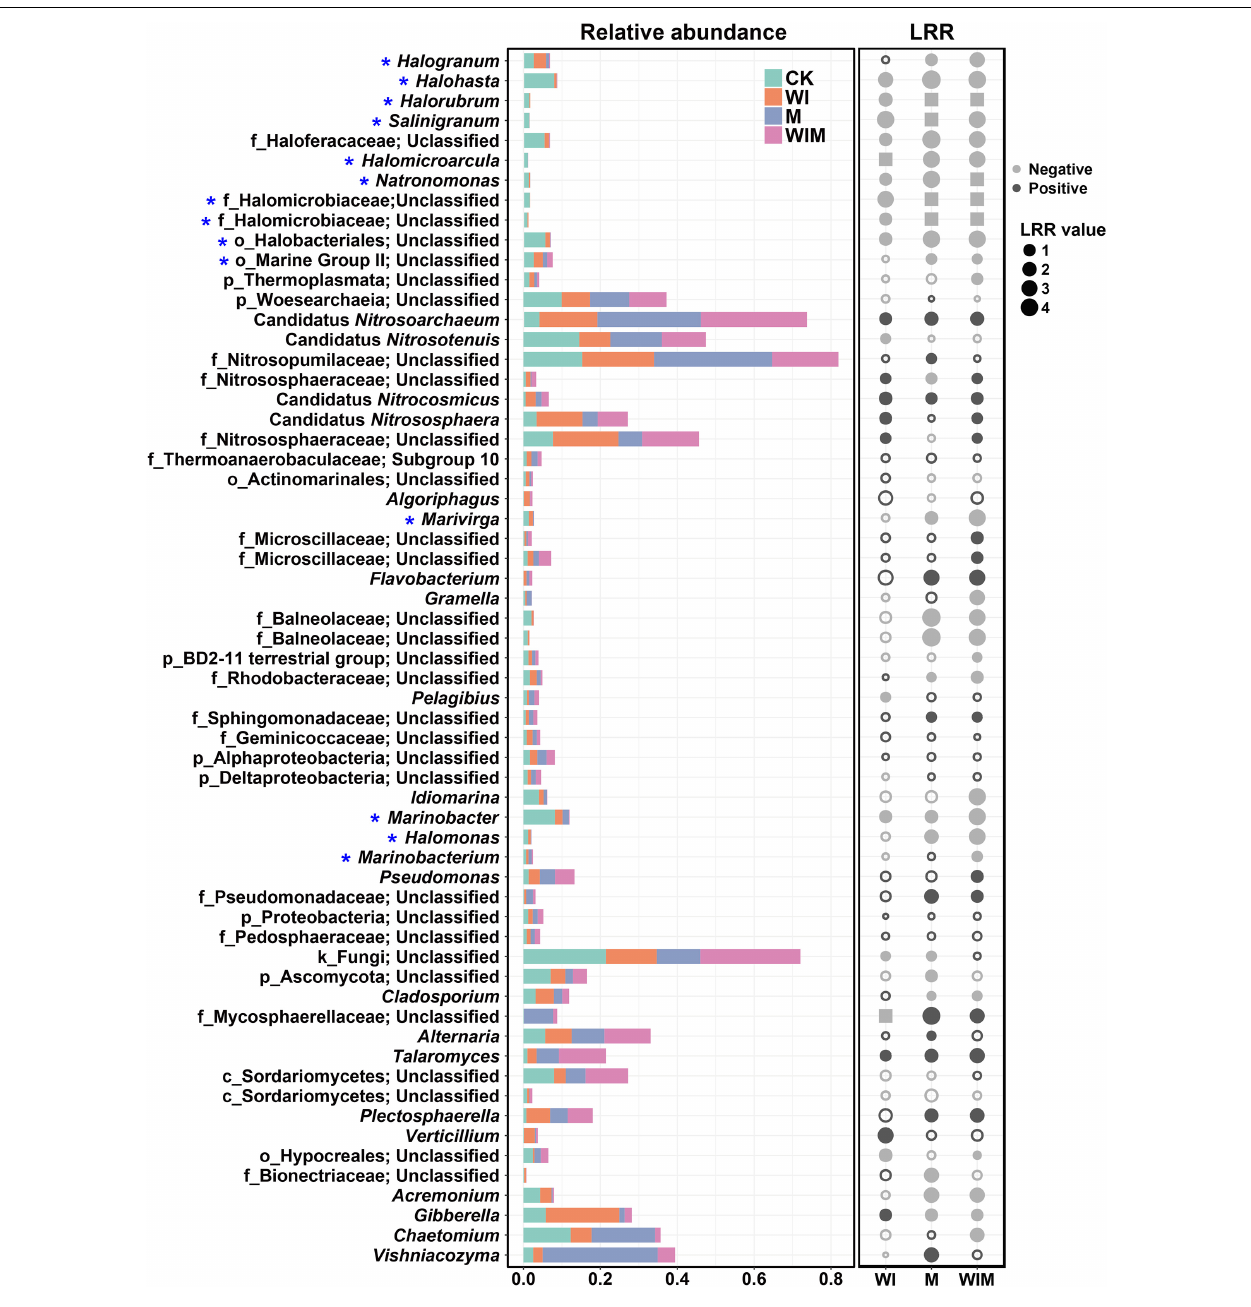
FIGURE 2 | Comparisons of the dominant genera of the soil microbial community in the 0–10 cm layer for different treatments (stacked plot) and the log response ratio (LRR) (dot plot) between the ameliorated soils (WI, M, and WIM) and the Control soil. Taxonomic level: k, kingdom; p, phylum; c, class; o, order; and f, family. The gray color in the dot plot indicates negative values, and the black color indicates positive values. Solid dots indicate significant differences in the relative abundance compared with the Control soil according to the Kruskal–Wallis rank sum test ( P < 0.05). The squares indicate that the genus was not detected (relative abundance: 0) in the amended soils. * Halophilic or haloduric taxa. WI, freezing saline water irrigation; M, plastic mulching; WIM, WI +